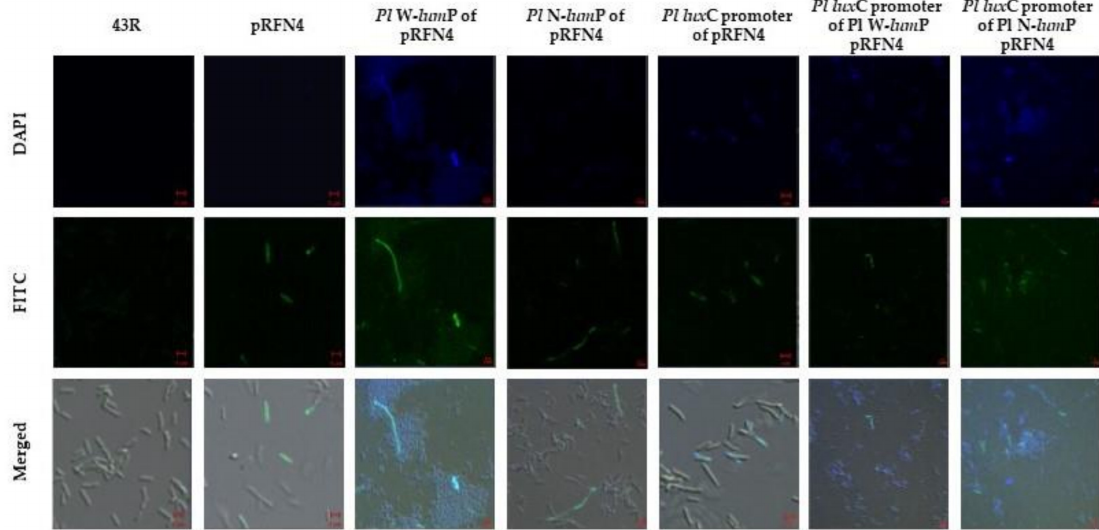
Figure 8. The microscopic images of E. coli 43R containing the recombinant plasmids of pRFN4 inserted the lux genes